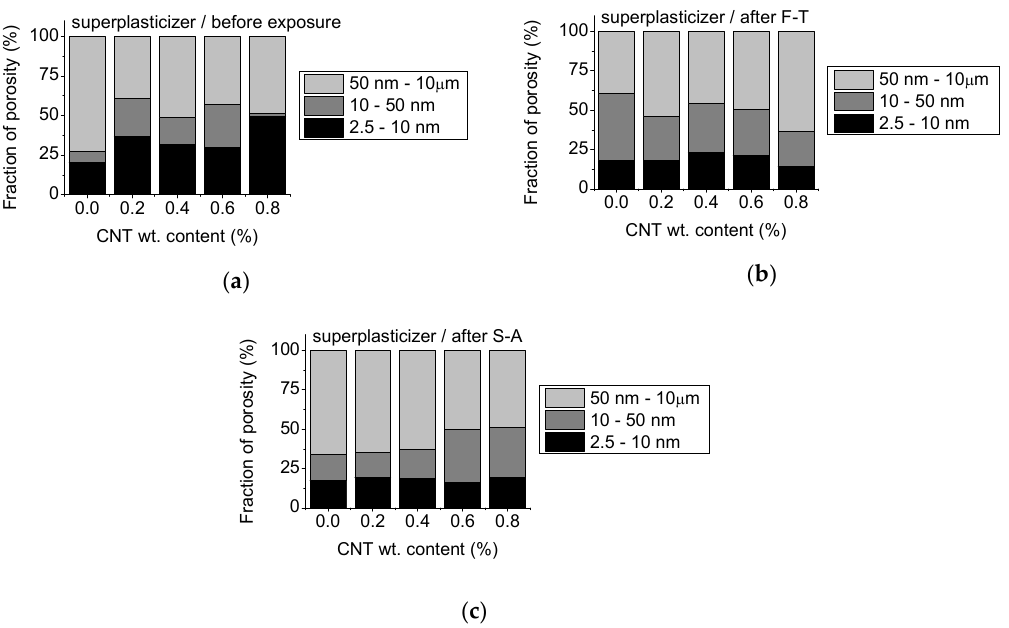
Figure 7. Fraction of gel (2.5–10 nm), medium capillary (10–50 nm) and large capillary (50 nm–10 µ m) pores of mortars prepared using superplasticizer as dispersant: ( a ) before exposure, ( b ) after F-T and ( c ) after